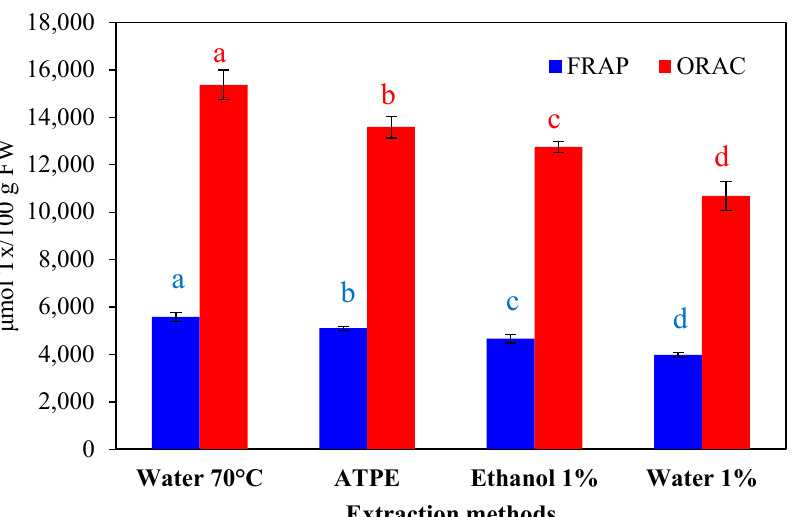
Figure 1. Antioxidant capacity of H. macrocarpa extracts measured in terms of FRAP and ORAC. Bars with different letters (a to d) at the same color, are significantly different ( p < 0.05).